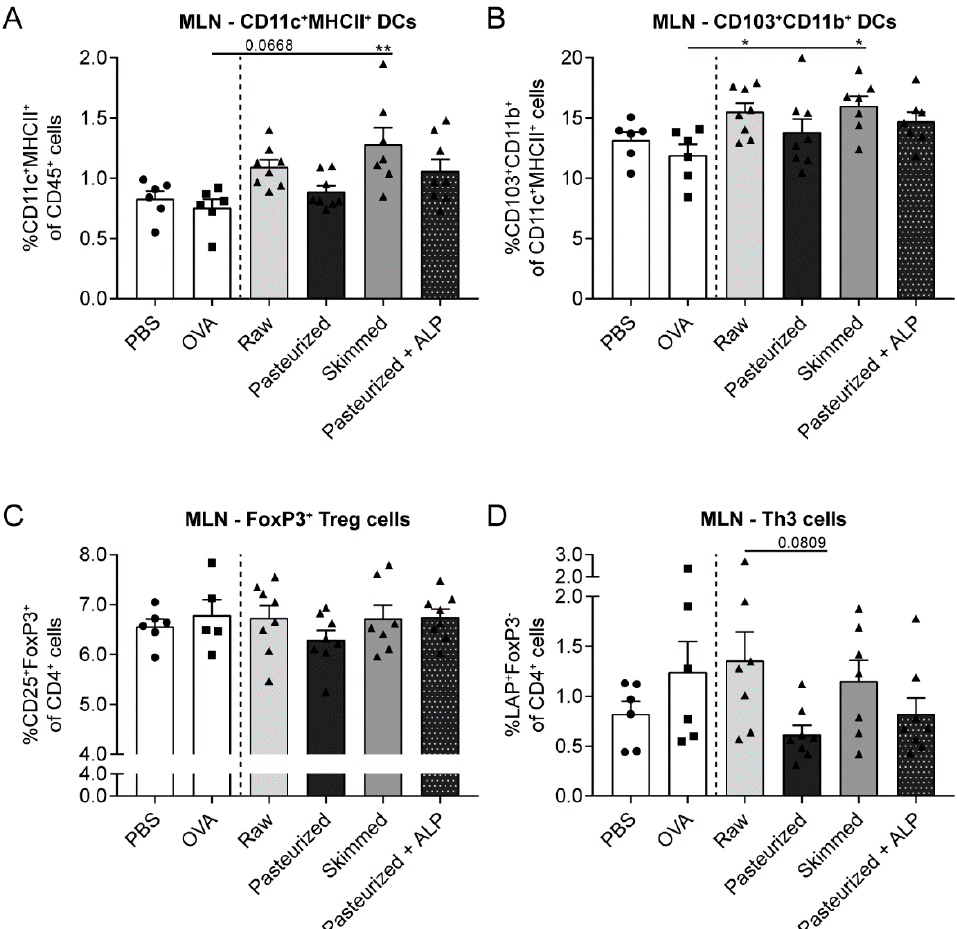
Figure 4. Induction of tolerance-associated cell types in the MLN of raw milk- and skimmed milk-treated mice. ( A ) Percentage of CD11c + MHCII + DCs (CD11c + MHCII + of CD45 + cells), ( B ) CD103 + CD11b + DCs (CD103 + CD11b + of CD11c + MHCII + cells), ( C ) FoxP3 + Treg cells (CD25 + FoxP3 + of CD4 + cells) and ( D ) Th3 cells (LAP + FoxP3 - of CD4 + cells) in the MLN. Data are presented as mean ± SEM, including individual data points, n = 6 in PBS group and n = 5–8 in all other groups. * P < 0.05, ** P < 0.01 as analyzed with one-way ANOVA followed by Bonferroni’s multiple comparisons test for pre-selected groups. MLN, mesenteric lymph nodes; PBS, phosphate-buffered saline; OVA, ovalbumin; raw, raw cow’s milk; pasteurized, pasteurized cow’s milk; skimmed, skimmed raw cow’s milk; pasteurized + ALP, pasteurized milk spiked with alkaline phosphatase.